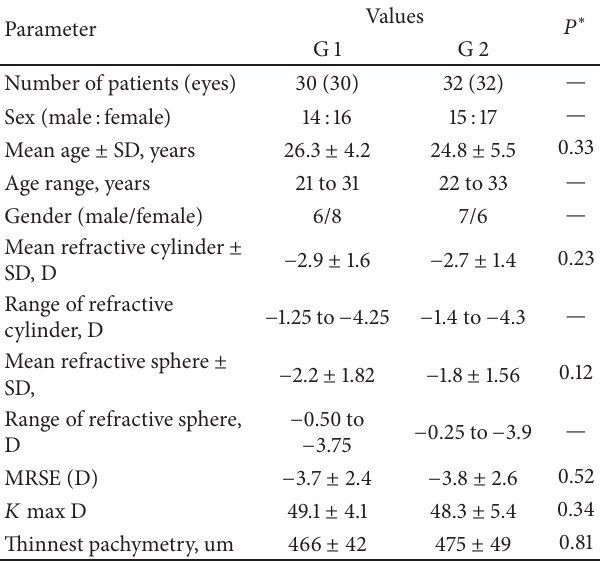
Table 1: Demographicinformation of thepopulation enrolled inthe study.